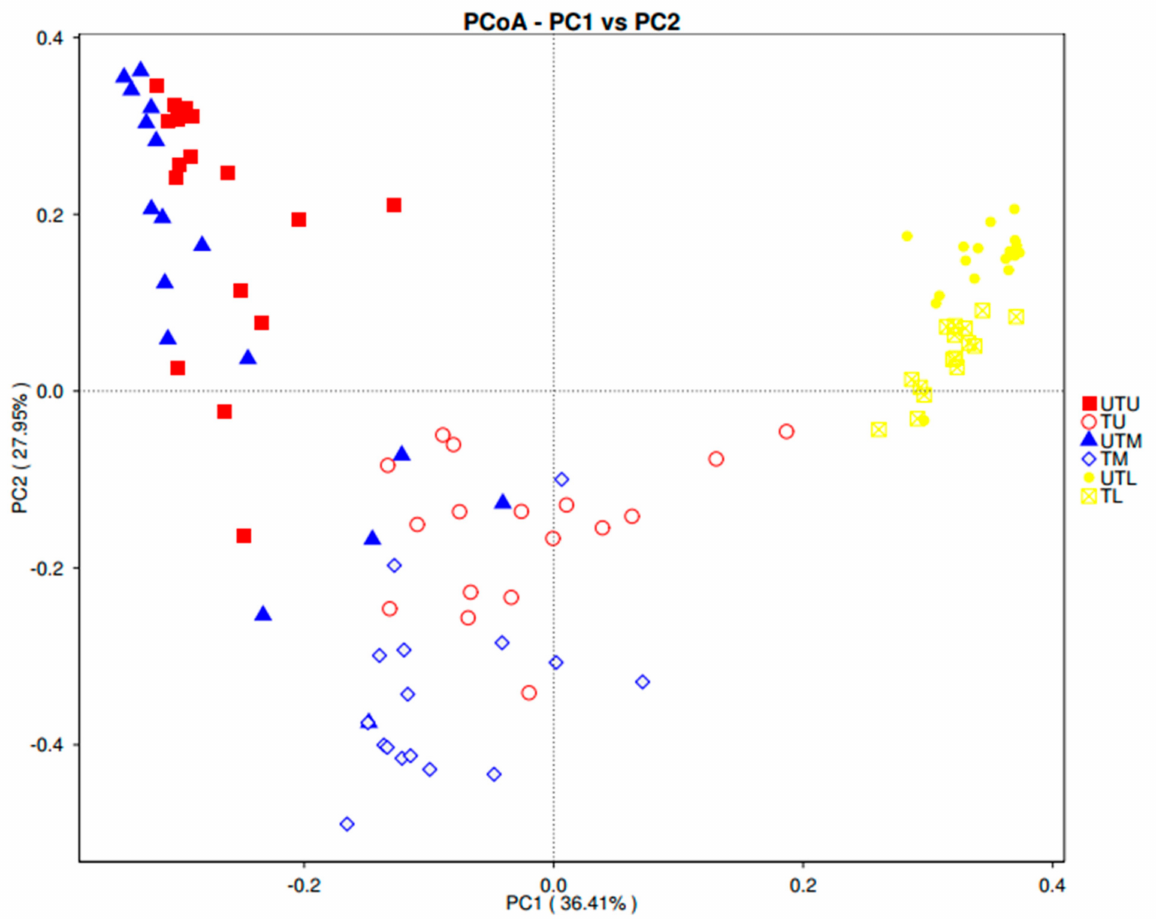
Figure 5. Weighted UniFrac PCoA illustrating the level of similarity between samples. Four distinct clusters were obtained: [1] TL; [2] UTL; [3] TU and TM; and [4] UTU